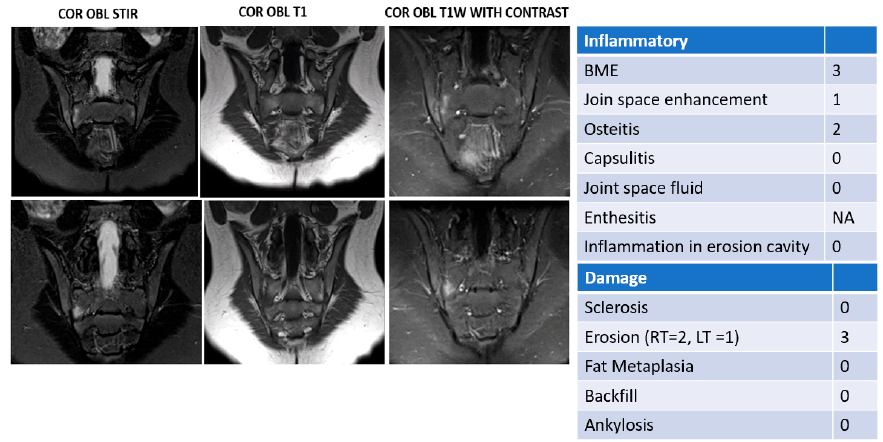
Figure A3. JAMRIS-SIJ image + grade vignette used for ranking exercise to test conjoint analysis survey (CAS)-derived weights. Fourteen image + grade vignettes were constructed corresponding to various combinations of pathologies in the JAMRIS-SIJ. Experts individually ranked the cases from the greatest to least level of inflammation and damage, respectively.